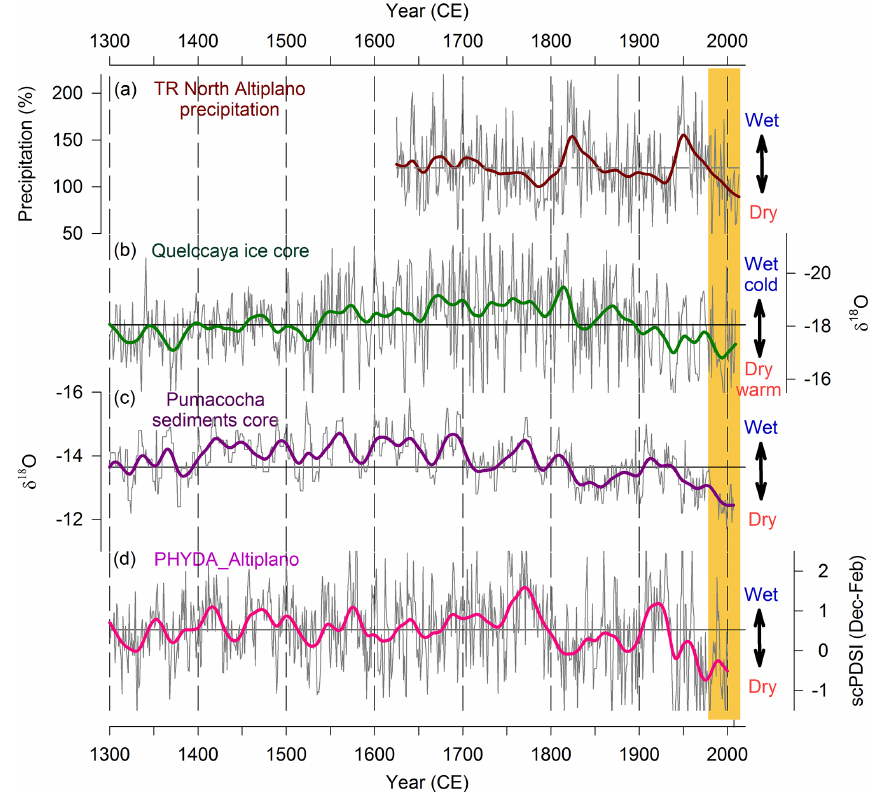
Figure 8. Comparison among four hydroclimate reconstructions from the central and southern sectors of the tropical Andes. The 35-year smoothed spline (thick colored lines) highlights the multi-decadal variability in the four paleoenvironmental records. From top to bottom: (a) precipitation from the northern sector of the Altiplano (this study); (b) the stable oxygen isotope ( δ 18 O) record from the Quelccaya ice core, Peru (Thompson et al., 2006); (c) the δ 18 O stable isotope record from Pumacocha lake sediment, Peru (Bird et al., 2011); and (d) the composite scPDSI from the entire Altiplano (17–23 ◦ S, 66–70 ◦ W, Steiger et al., 2018). Shaded background represents drought period (yellow) shared among the four